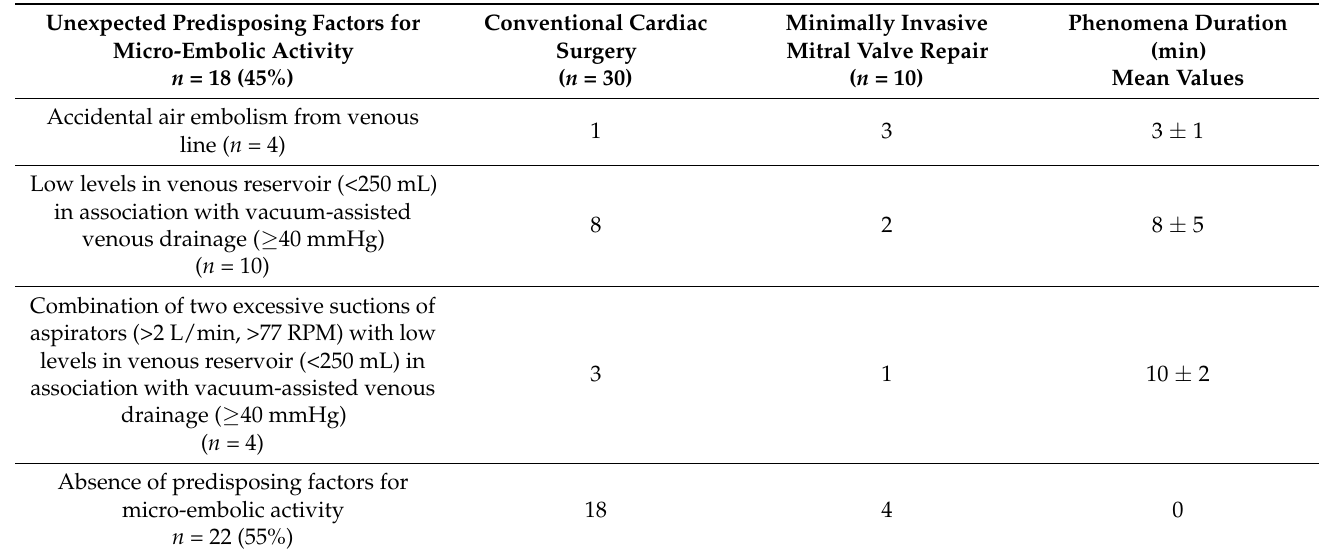
Table 3. Incidence of micro-embolic activity for procedures and duration.